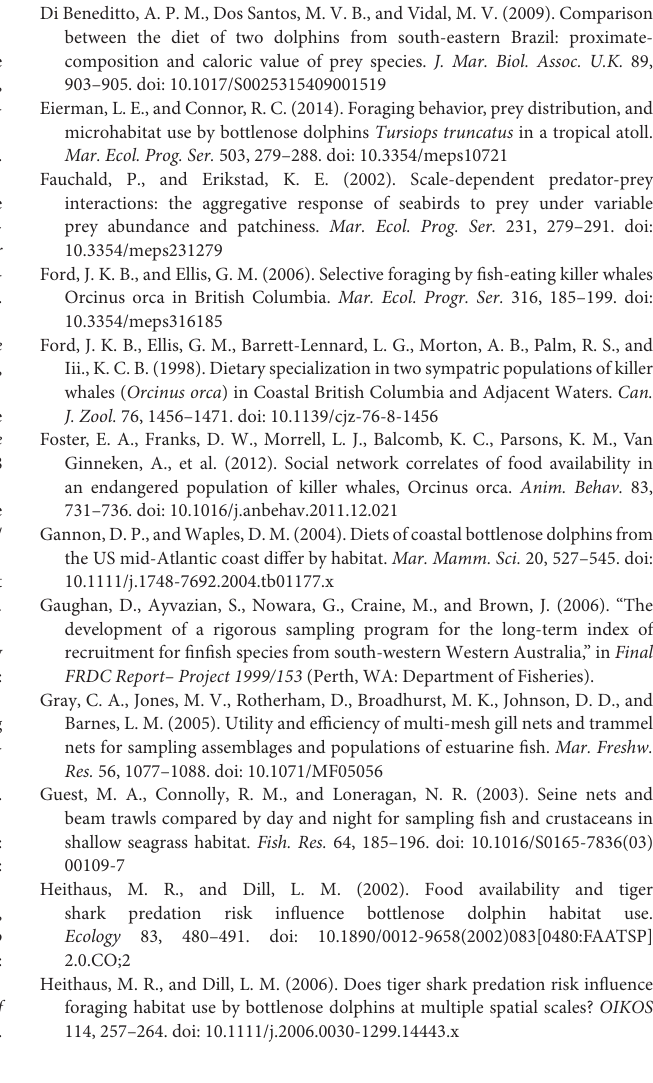
Figure 1 . K. Sprogis provided valuable suggestions on